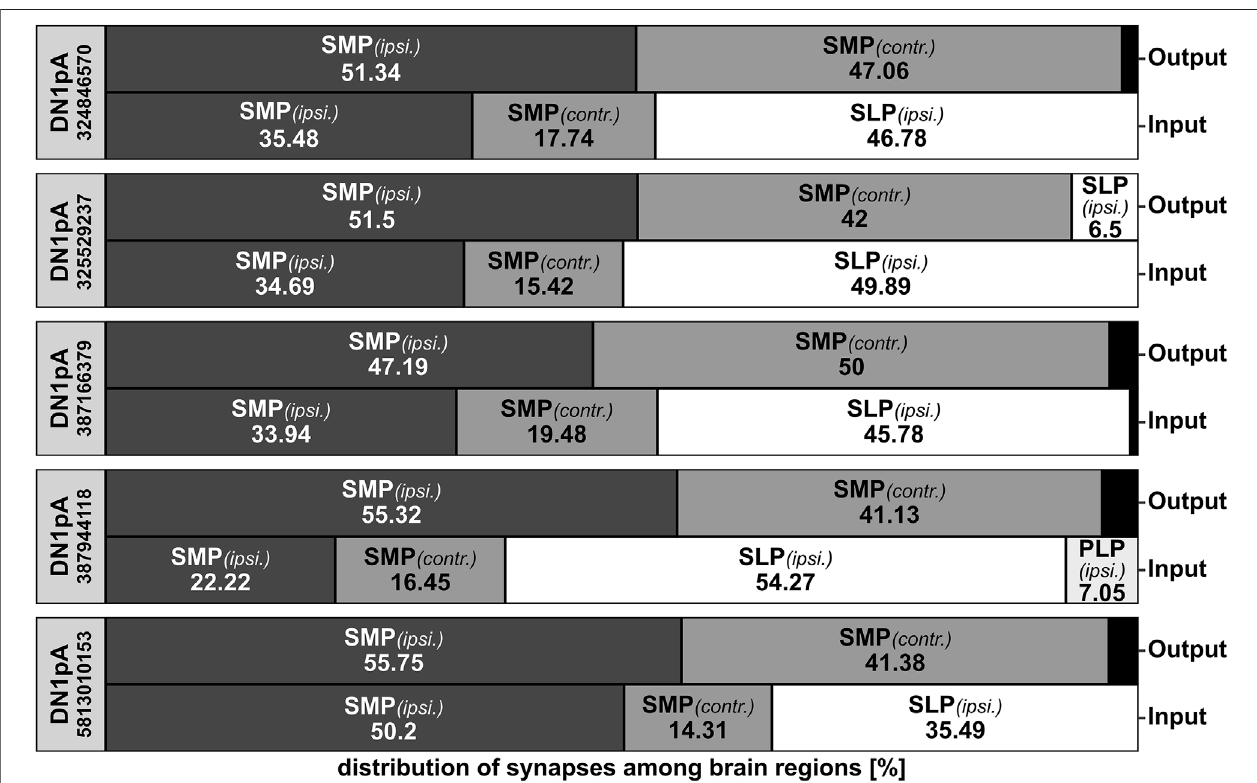
FIGURE8| Distributionofthe synapses ofthe fi veannotatedhemibraintype ADN 1p samong thebrainregions. Thetype ADN 1p srestricttheiroutputmainly tothe ipsilateral (ipsi.) and contralateral (contr.) superior medial protocerebrum (SMP) while they get about 50% of their input additionally from the ipsilateral superior lateral protocerebrum(SLP).TheCRY-positiveDN 1p oftypeA(#387944118,greenin Figure6 )thatsends fi berstotheposteriorlateralprotocerebrum(PLP)istheonlyneuron thatreceivesinputfromthere.Inaddition,thisneuronreceivesmostinputfromtheSLP,towhichitsendsadendritic fi berfollowingthelooparoundtheSLPtoward the